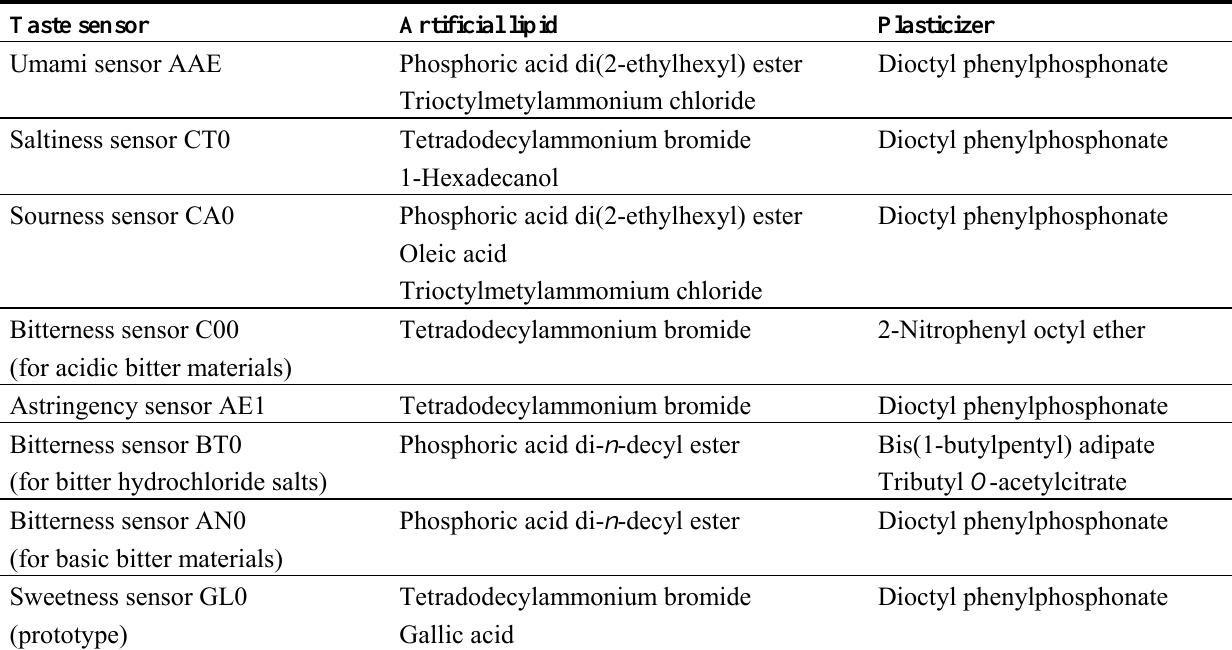
Table 2. Chemical components of taste sensors.